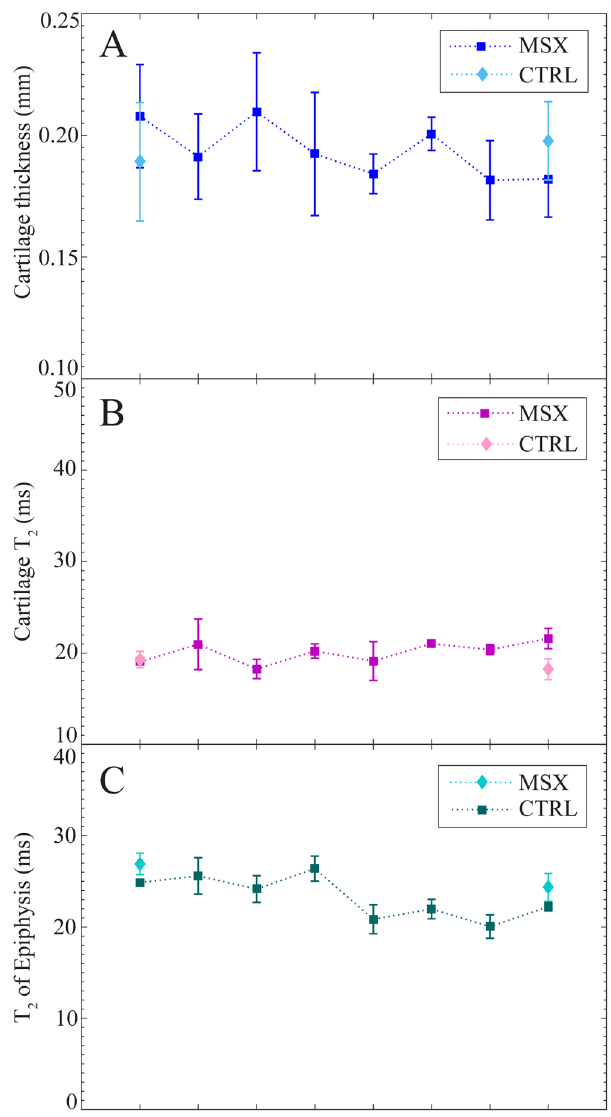
Figure 7. Changes in the tissues of the lateral condyles of MSX joints, in comparison to lateral condyle controls, during the eight week observation period post meniscectomy. Cartilage thickness ( A ), cartilage T 2 (B) and T 2 of epiphysis ( C ) of CTRL and MSX joints are plotted for week 1–week 8 for central coronal slice location. Data plotted as mean ±